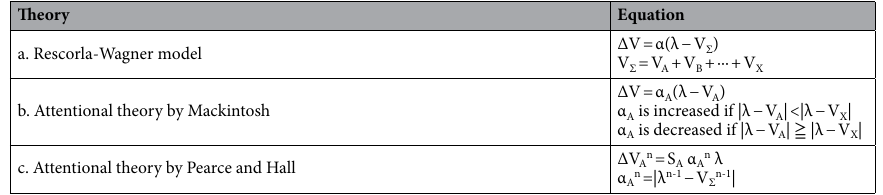
Table 1. Learning theories to account for blocking. V: associative strength, which corresponds to US prediction; V A , V B and V X : associative strength for stimuli A, B and X, respectively; ΔV: change in associative strength in a particular trial; α: learning-rate parameter reflecting attentional process (0 < α < 1); α An : learning- rate parameter for stimulus A in trial n; λ: maximum strength that the CS-US association can achieve, set by the magnitude of the US; S: salience, which corresponds to intensity of the stimulus. Description of the equations follows Pearce and Hall 4 with little modification.